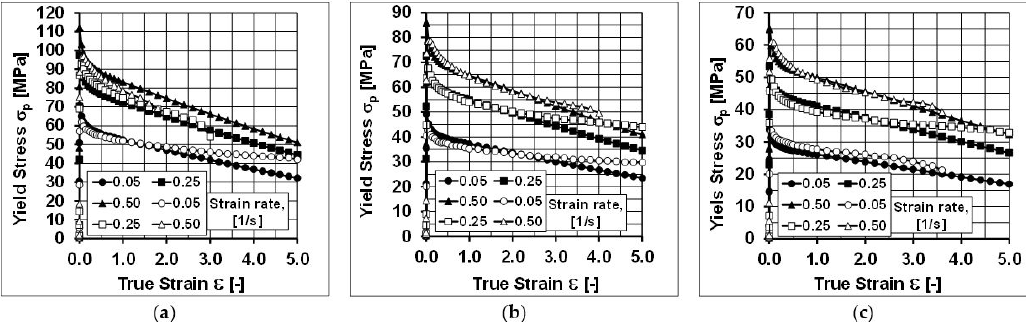
Figure 5. Flow curves of the 5019 aluminium alloy at temperatures of ( a ) 440 ◦ C; ( b ) 480 ◦ C; ( c ) 520 ◦ C; empty symbols— plastometric test data; full symbols—results after approximation using coefficients from Table 1 (Variant